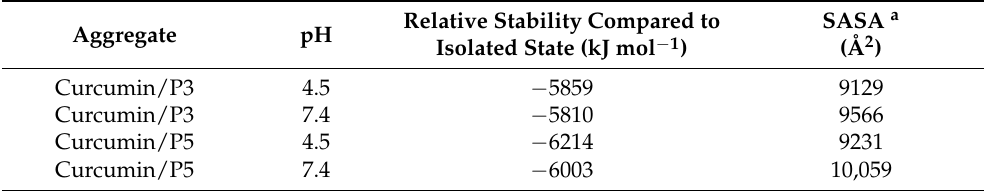
Table 5. Relative stability with respect to isolated state of 10 curcumin molecules and 20 P3- or P5- carriers, and the solvent accessible surface area (Å 2 ) of P3- and P5-curcumin aggregates at different pH values in the optimized geometries at the end of MD